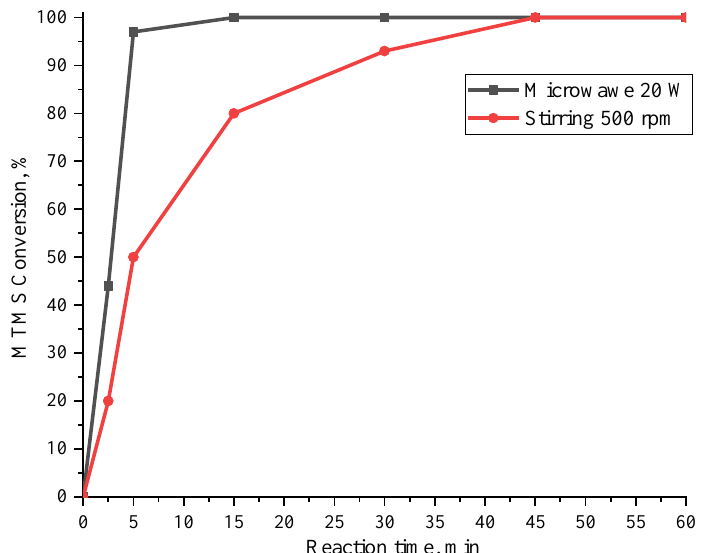
Figure 6. Curves of monomer conversion versus time for MTMS hydrolytic polycondensation under MW radiation (20 W) and without radiation with stirring (500 rpm) at a MTMS/H 2 O molar ratio of 1/3 and at 30 °C.